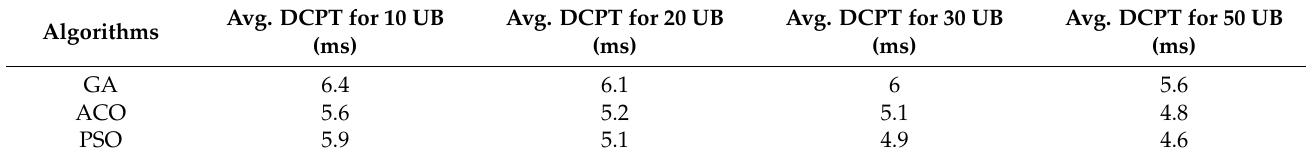
Table 11. Performance analysis of avg. DCPT for 10, 20, 30, and 50 UB with 5 DC.